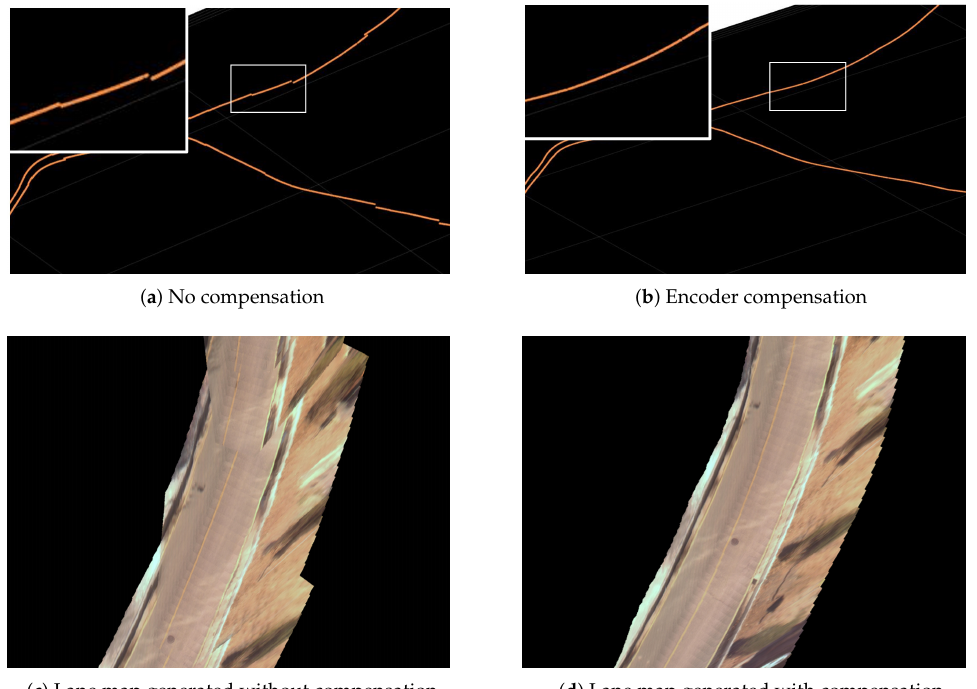
Figure 10. Result of self-consistent lane map process. Left ( a , c ) and right ( b , d ) images show the result of lane map.